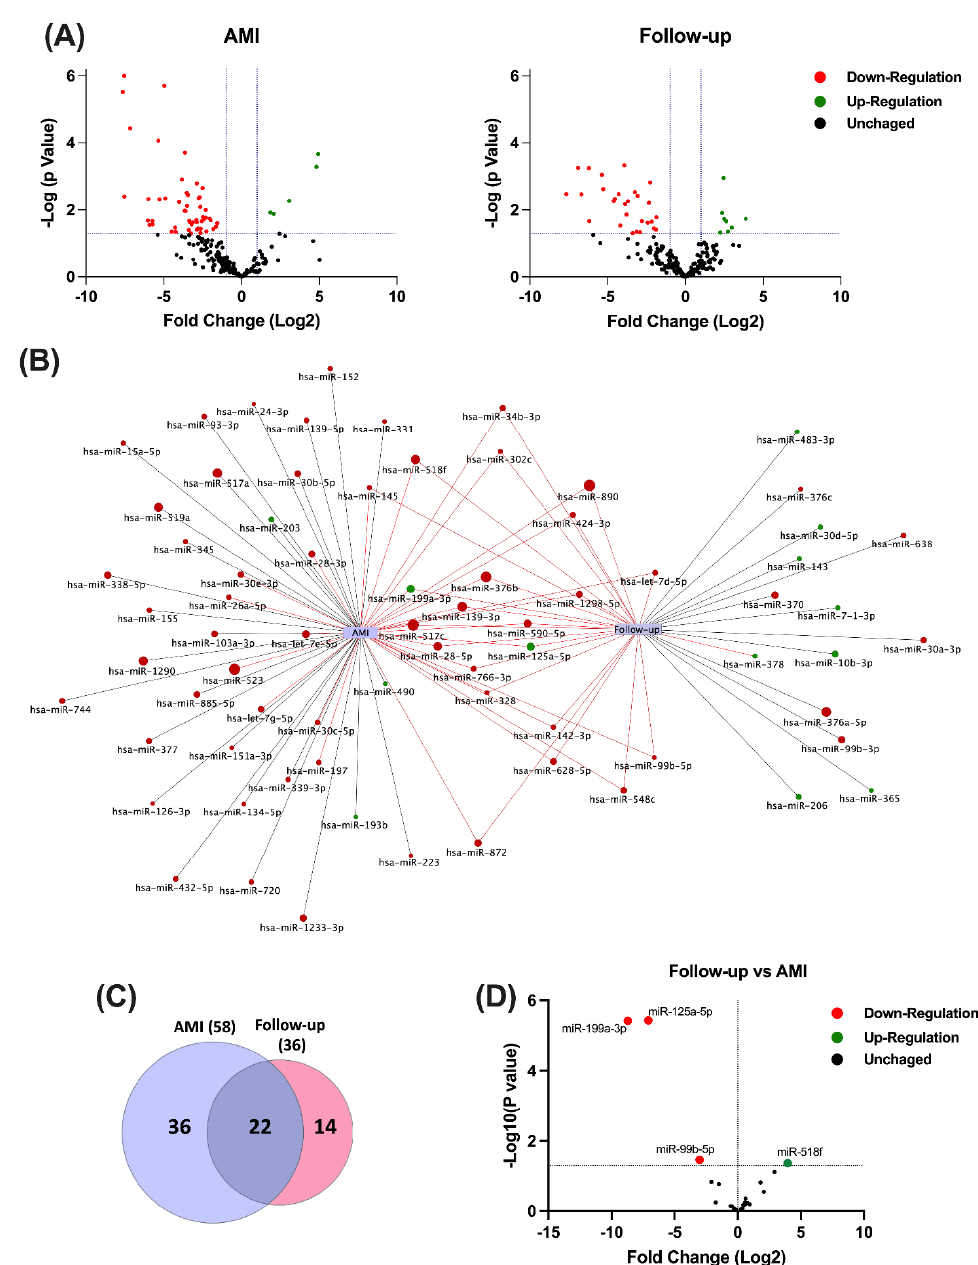
Figure 2. Circulating miRNA expression profile in serum of NSTEMI patients during acute event (AMI) and after 1 year (Follow-up). ( A ) Volcano plots show the values of fold change (Log2, x-axis) by the adjusted p -value ( − Log10 of p -value, y-axis). The colors represent genes or miRNAs that were at least 2-fold downregulated (red) or upregulated (green) in AMI ( n = 8) and Follow-up ( n = 8) relative to healthy control samples. ( B ) Network visualization of miRNAs significantly modified in the acute event AMI and at 1-year follow-up ( p > 0.05). Shown are the miRNA exclusively expressed in each group (black edges) and those shared across both groups (red edges). Size of nodes are associated to the degree of fold change (Log2) of miRNAs that are down-regulated (red nodes) or up-regulated (green nodes). ( C ) Venn diagram and hierarchical clustering representing differentially expressed miRNAs found in AMI and Follow-up groups. ( D ) Volcano plot showing the comparative expression [Fold change (Log2), x-axis] by the adjusted p -value ( − Log10 of p -value, y-axis) of miRNAs that were shared across AMI and Follow-up groups. Relative changes in miRNA expression were analyzed by multiple t -test with Holm–Sidak